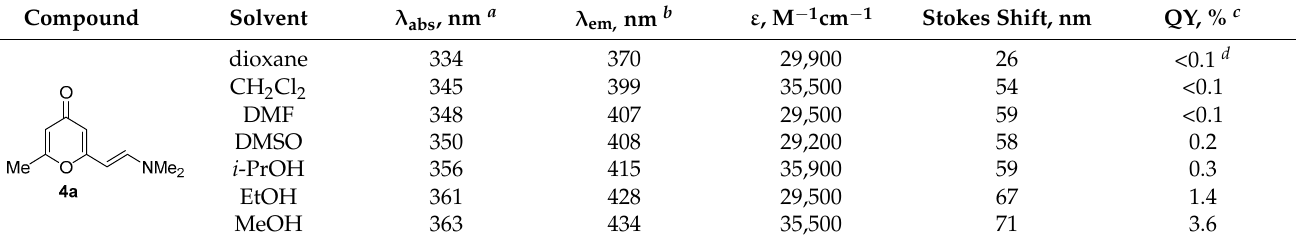
described method